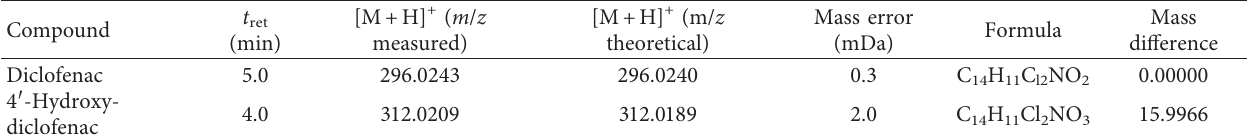
Table 2: Diclofenac and its biotransformation product defined by their retention times, measured and theoretical protonated molecules (fragment ions), and formula.